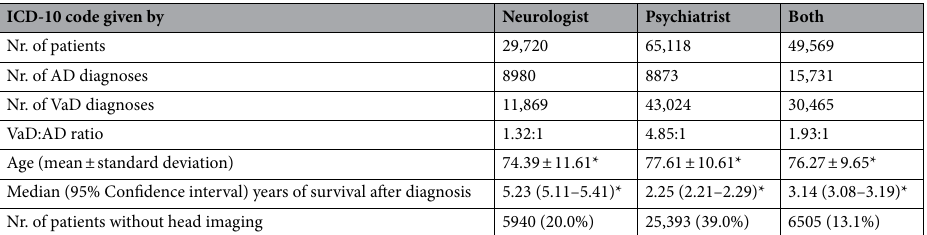
Table 3. Comparison of the neurological and psychiatric diagnoses. Patients were categorized according to which specialty gave the dementia diagnosis. The three groups are patient who were diagnosed only by neurological or psychiatric specialty or got diagnosis from both specialties. AD and VaD categories include the mixed pathologies as well. Differences between the mean age were significant (one-way ANOVA, *p < 0.00002), the same was observed between the survival after the dementia diagnosis (logrank test, *p < 0.0001). Nr. Number.